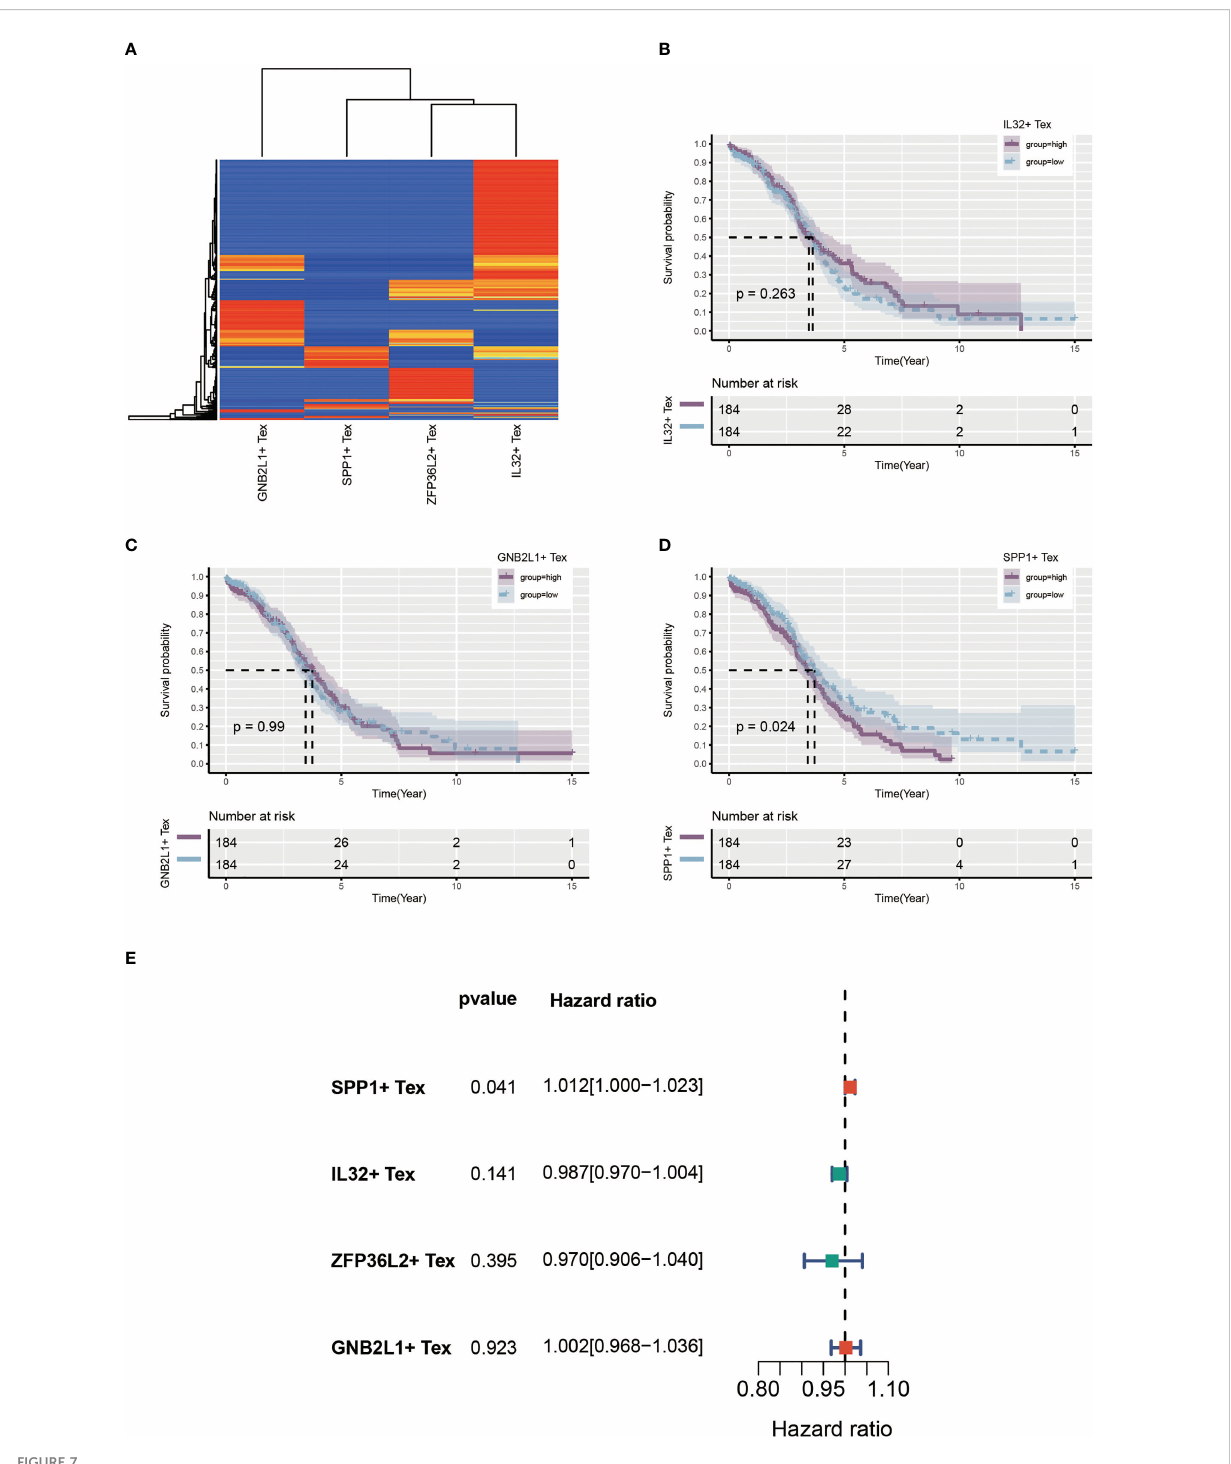
FIGURE 7 Identify Tex-related cellular features. (A) Heat map showing expression of four Tex-related cells in the TCGA cohort. (B-D) Survival curves showing survival differences between the three Tex cells in the high and low groups divided according to the median. (E) Forest plot showing the results of univariate cox